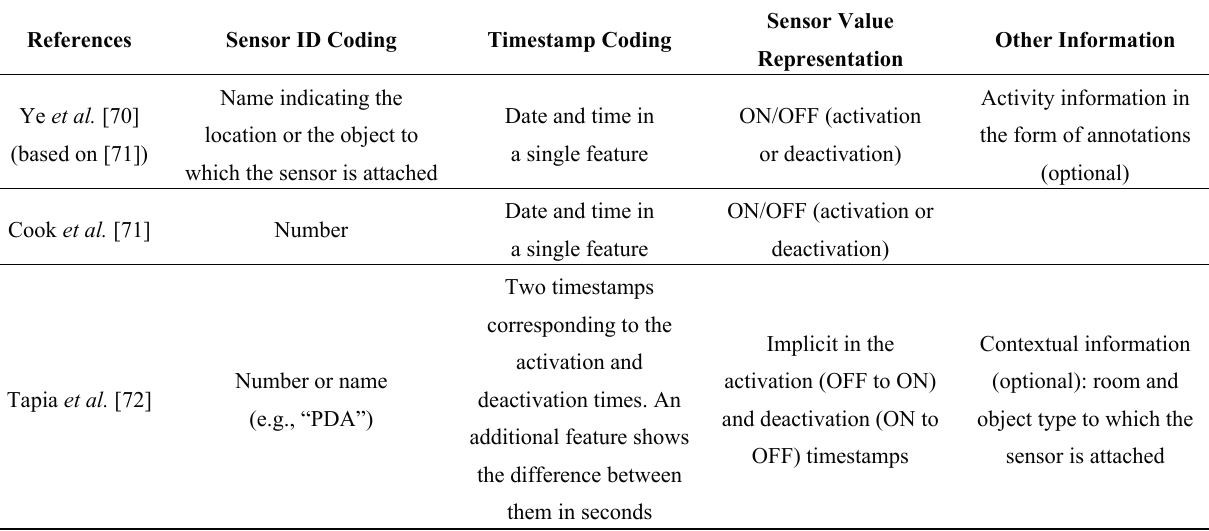
Table 2. Differences in the format of three datasets collected from real world smart home environments (based on information in